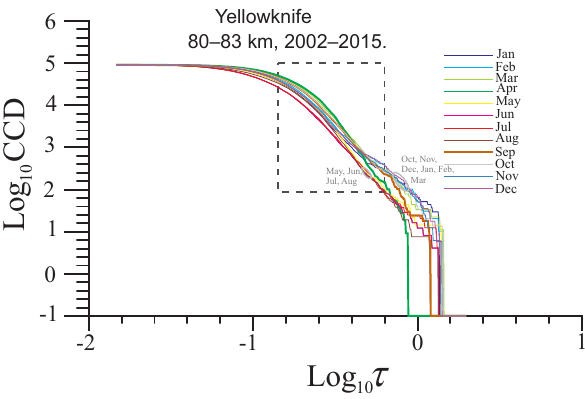
Figure 4. This figure shows a repeat of Fig. 1, but this time showing all months of the years. Notice that the months May to August form one cluster (summertime) and October to March form another (win- tertime), but the months of April and September show a distinctly different behaviour. April in particular stands out and is highlighted with an extra-thick green line. In particular, the slope of this green line in the range − 0.6<log 10 τ < − 0.2 is clearly much steeper (more negative) than the slopes for the other months. The same is true, but to a lesser extent, for the month of September.